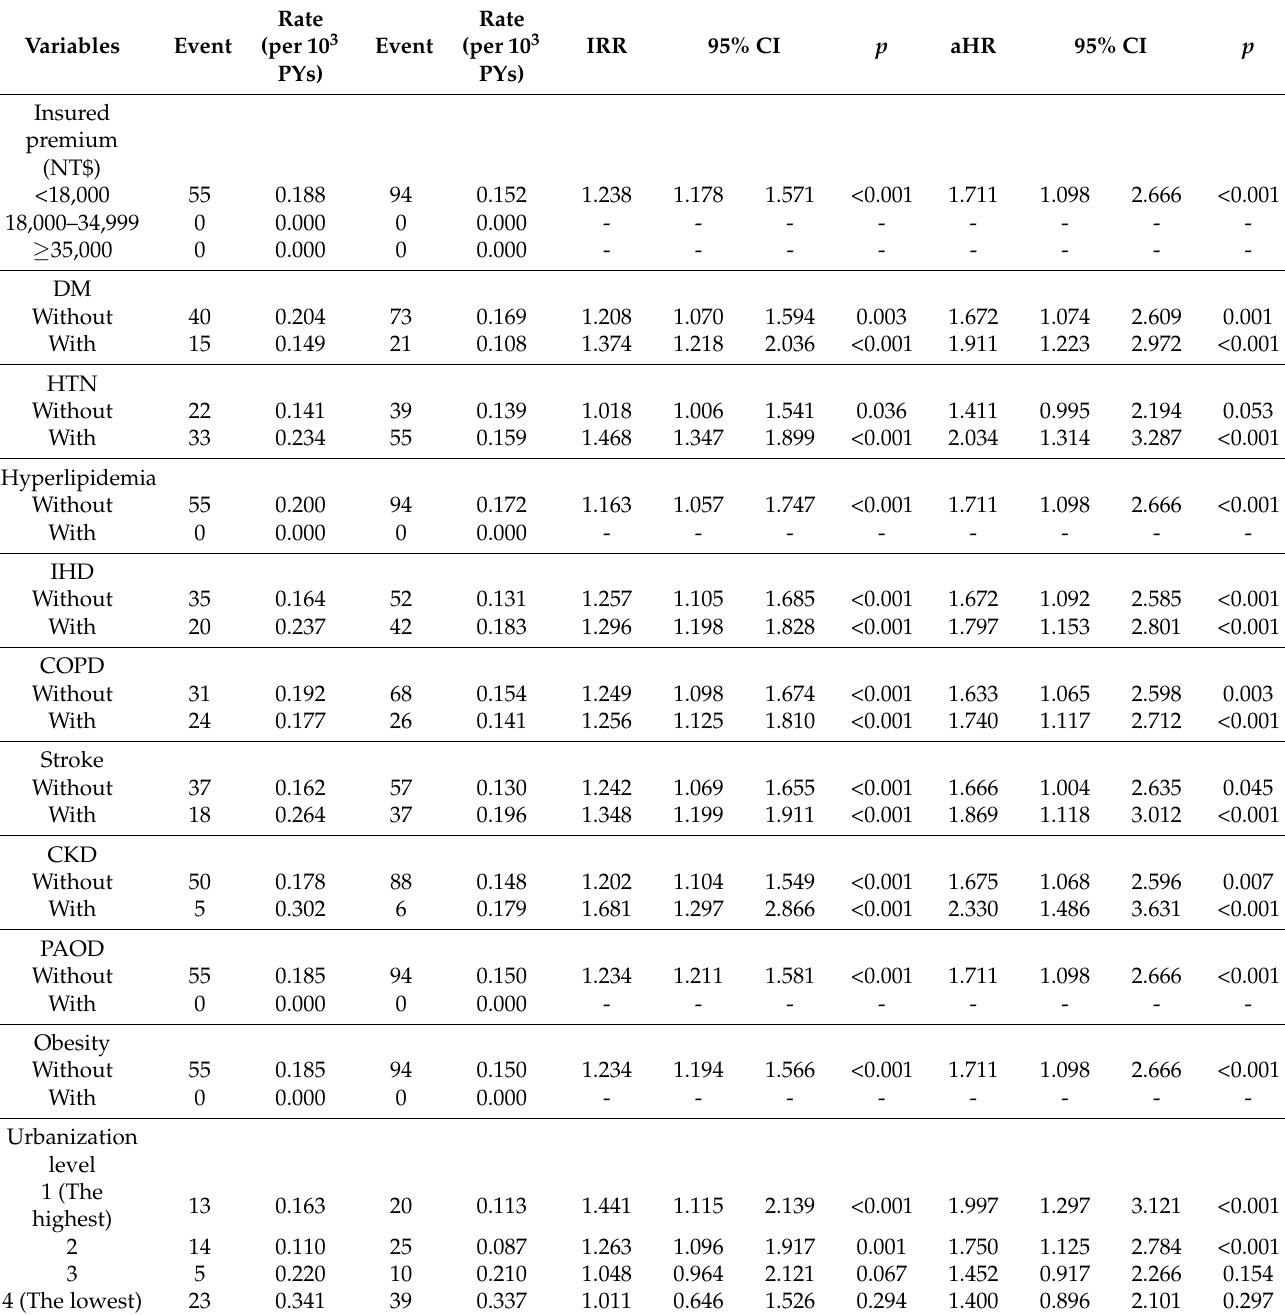
PYs = person-years, aHR = adjusted hazard ratio: adjusted for the variables listed in Table 2, CI = confidence interval, IRR = incidence rate ratio, TB = tuberculosis, DM = diabetes mellitus, HTN = hypertension, IHD = ischemic heart disease, COPD = chronic obstructive pulmonary disease, CKD = chronic kidney disease, PAOD = peripheral arterial occlusive